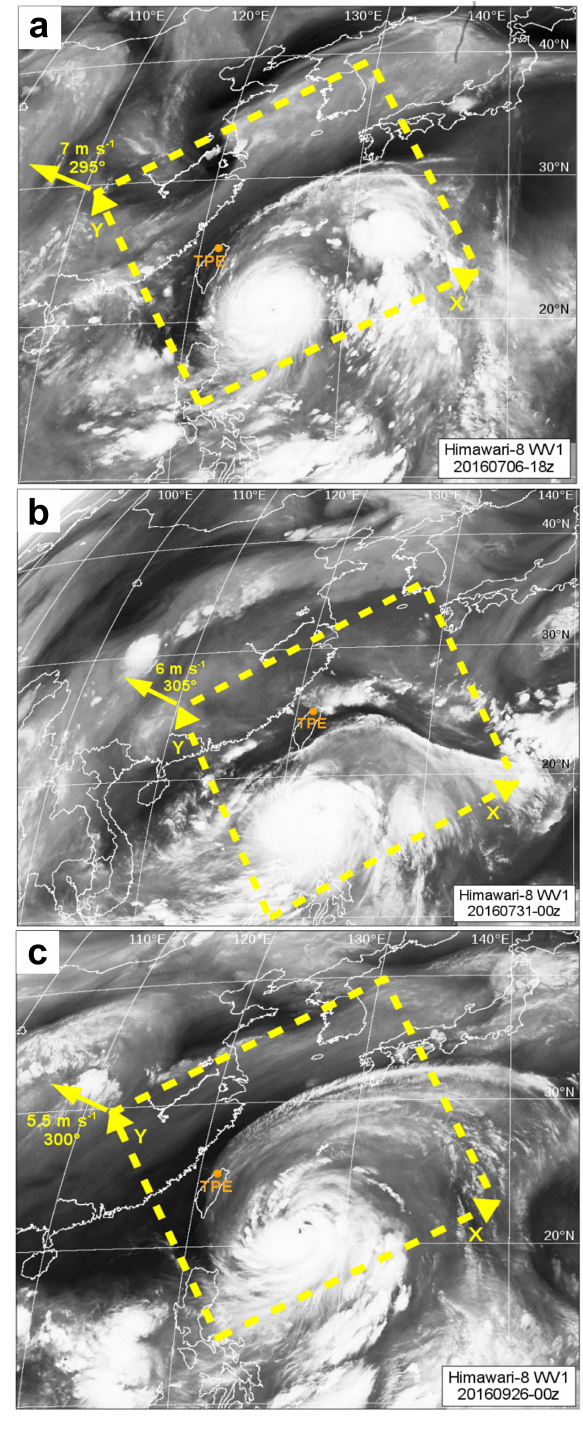
Figure 5. Himawari-8 Channel 8 (6.06–6.43µm) “Water Vapor” im- ages on (a) 6 July 2016 at 18:00UTC for Typhoon Nepartak, (b) 31 July 2016 at 00:00UTC for Severe Tropical Storm Nida and (c) 26 September 2016 at 00:00UTC for Typhoon Megi. Orange dot la- belled TPE indicates the location of the Taiwan Taoyuan Interna- tional airport. The yellow boxes denote the 2000km × 2000km re- gion where ERA-5 reanalyses data were composited ( x and y axes and storm motion are indicated) for each